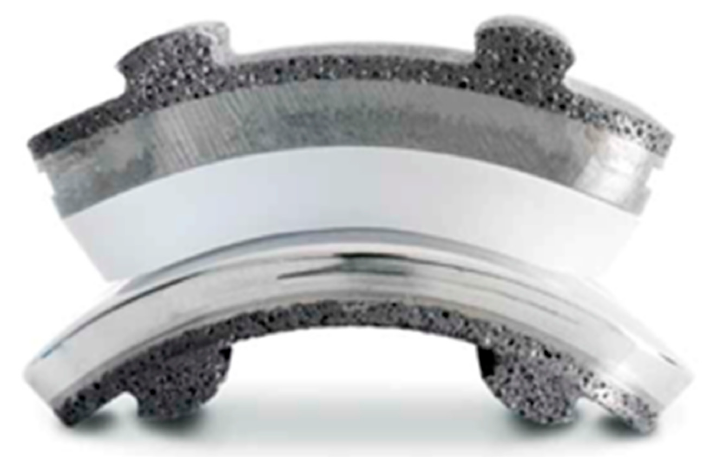
Figure 6. Zimmer TAR prosthesis.